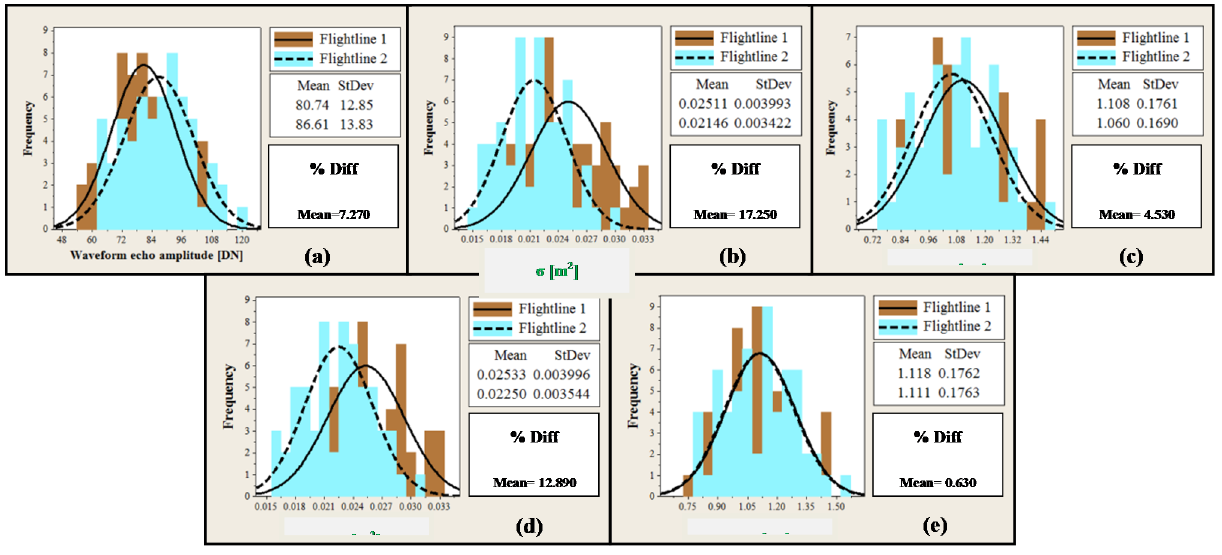
Figure 3. Histograms and statistics for the backscatter signals before and after calibration of a selected road target from overlapping flightlines: ( a ) the original amplitude signals; ( b – e ) the four backscatter parameters (σ, γ, σ α , γ α ) respectively after calibration through the developed routine. (Mean and StDev values in the second box refer to flightline 1 and flightline 2,